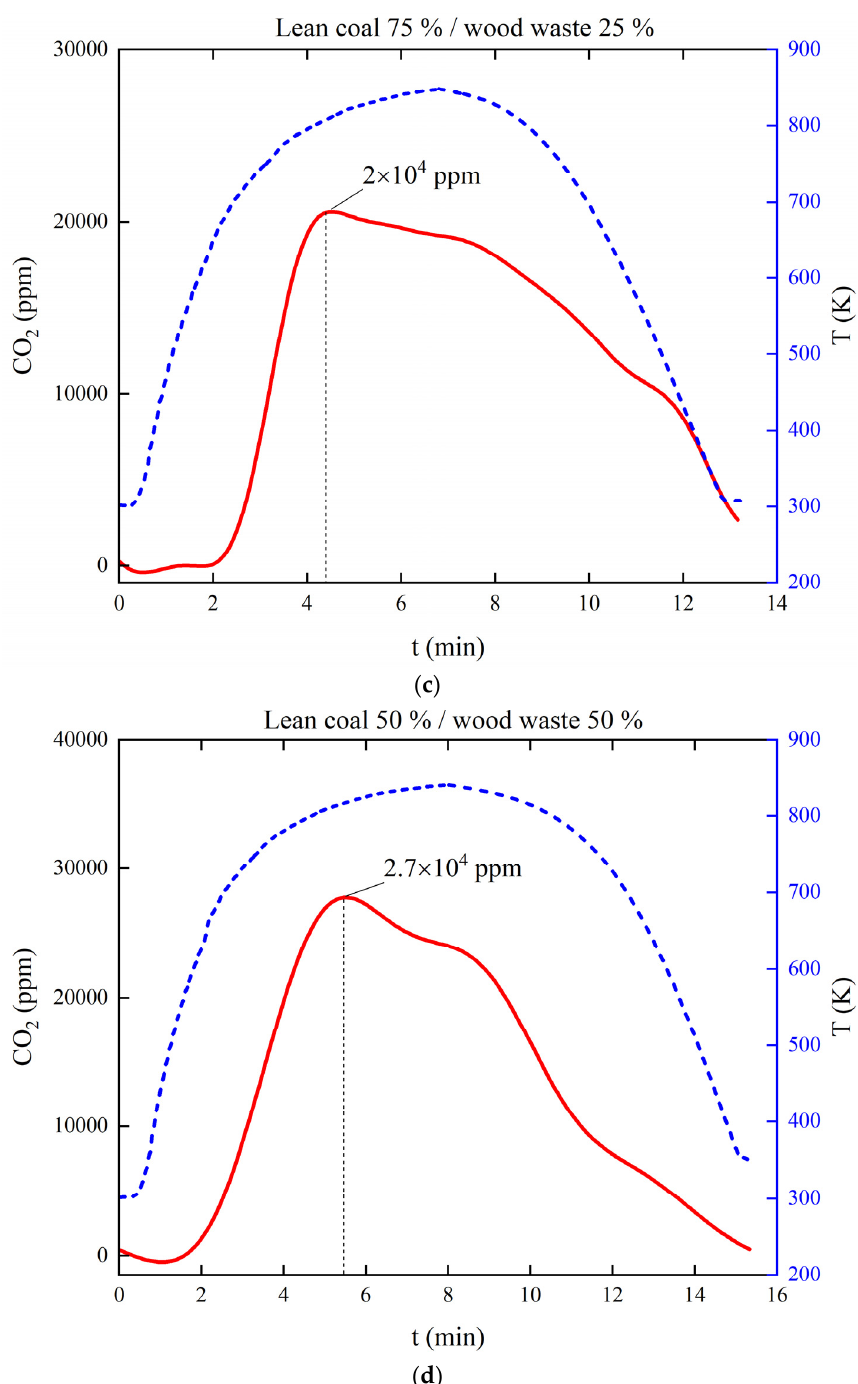
Figure 8. Changes in the concentration of carbon dioxide in the gaseous products of the thermal decomposition of mixed fuels based on T-grade coal and wood with a change in the proportion of the latter in the mixture from 10% to 50%: ( a ) lean coal 100%; ( b ) lean coal 90%/wood waste 10%; ( c ) lean coal 75%/wood waste 25%; ( d ) lean coal 50%/wood waste 50%.